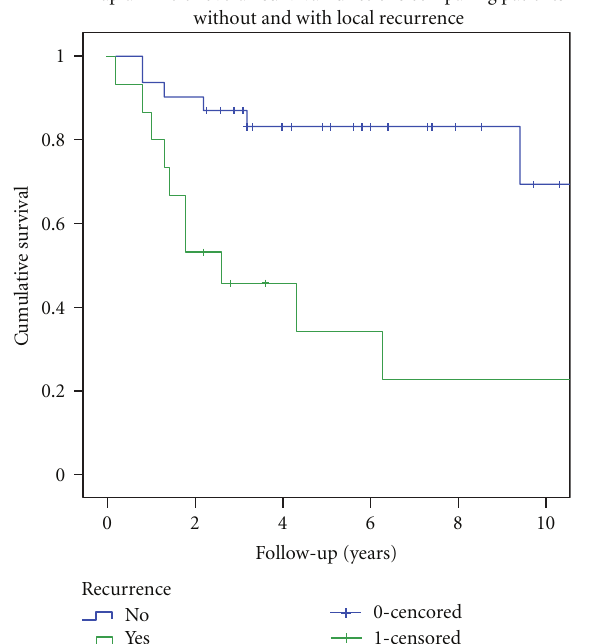
Figure 2: Kaplan-Meier overall survival curves comparing patients with and without local recurrence. Log Rank univariate analyses demonstrated significance ( P = 0 .